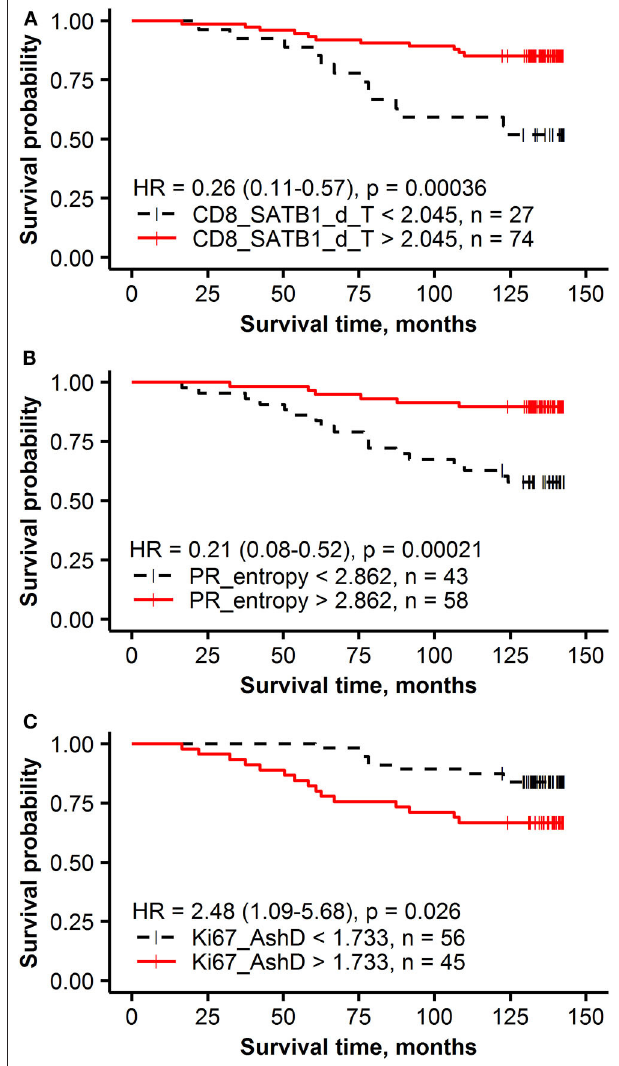
FIGURE 3 | Kaplan-Meier survival plots with hazard ratio and log-rank test for correlation of IHC and intratumoral heterogeneity indicators with overall survival: (A) the density of CD8 + SATB1 + in the tumor compartment (T), (B) PR entropy, (C) Ki67 Ashman’s D